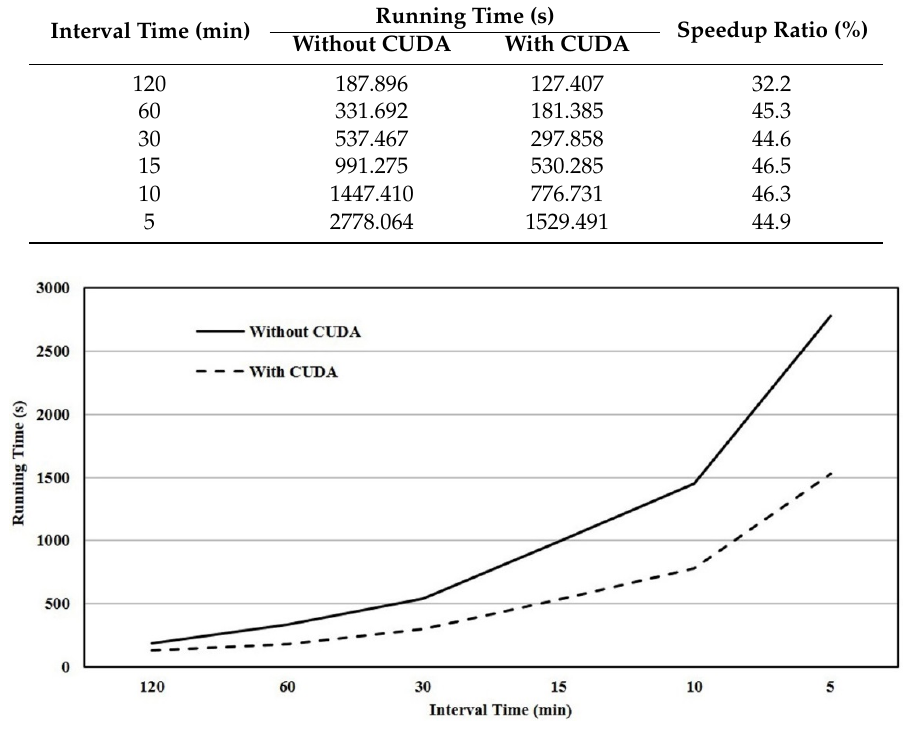
Figure 8. Trend of running time with or without Compute Unified Device Architecture (CUDA).